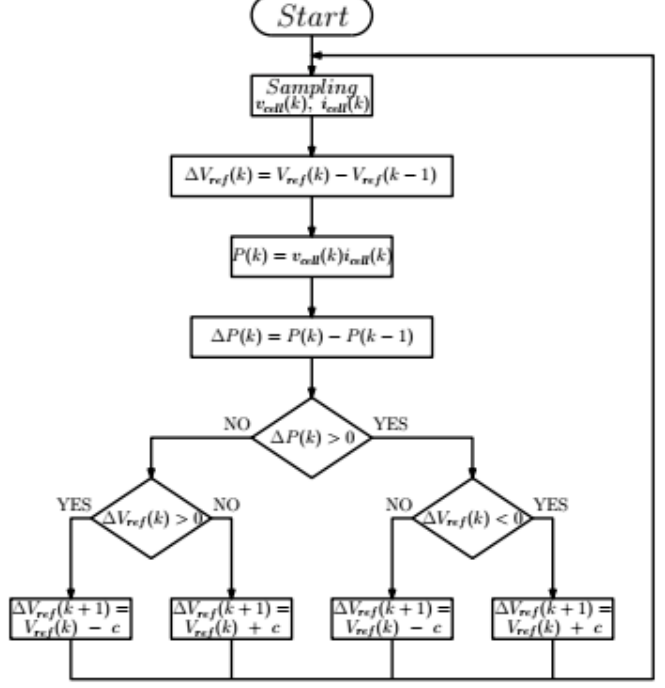
Figure 4. Perturb and observe (P and O) algorithm.